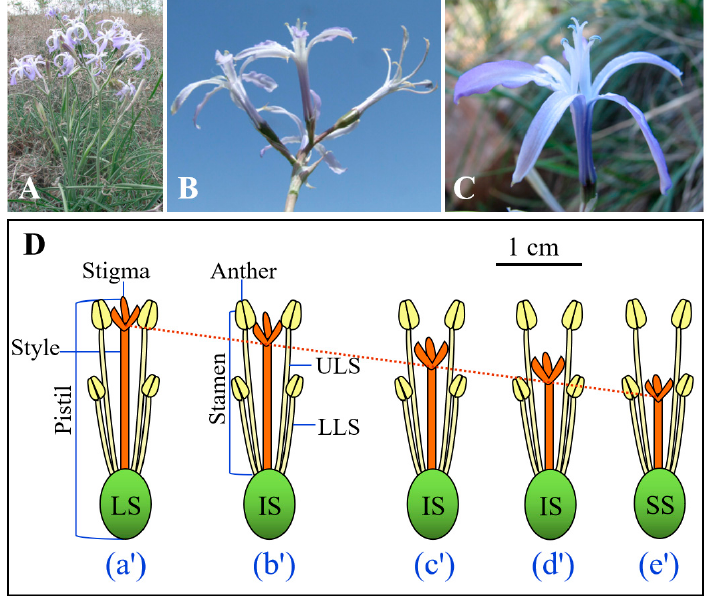
Figure 1. ( A ) Several plants in flower, ( B ) inflorescence of a single plant, ( C ) a flower and ( D ) diagrams illustrating continuous variation in style length for Ixiolirion songaricum . ( a’ ) Plant with a single floral phenotype in which stigma and anthers of long stamens are of equivalent height long style (LS). Three plants ( b’ – d’ ), each with a single floral phenotype, in which stigma and anthers are spatially separated (herkogamy), intermediate style (IS). ( e’ ) Plant with a single floral phenotype in which stigma and anthers of short stamens are of equivalent height short style (SS). ULS, upper-level stamen; LLS, lower-level stamen. The red-dashed line shows the style length continuum.